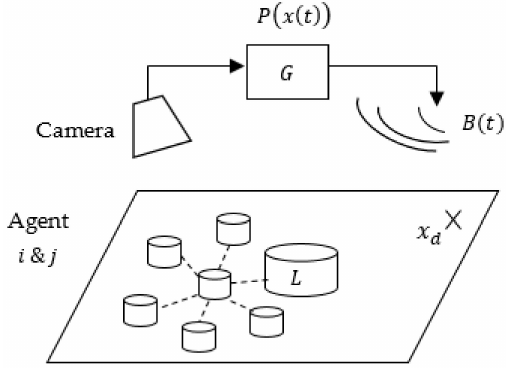
Figure 1. Multi-agent broadcast communication environment.